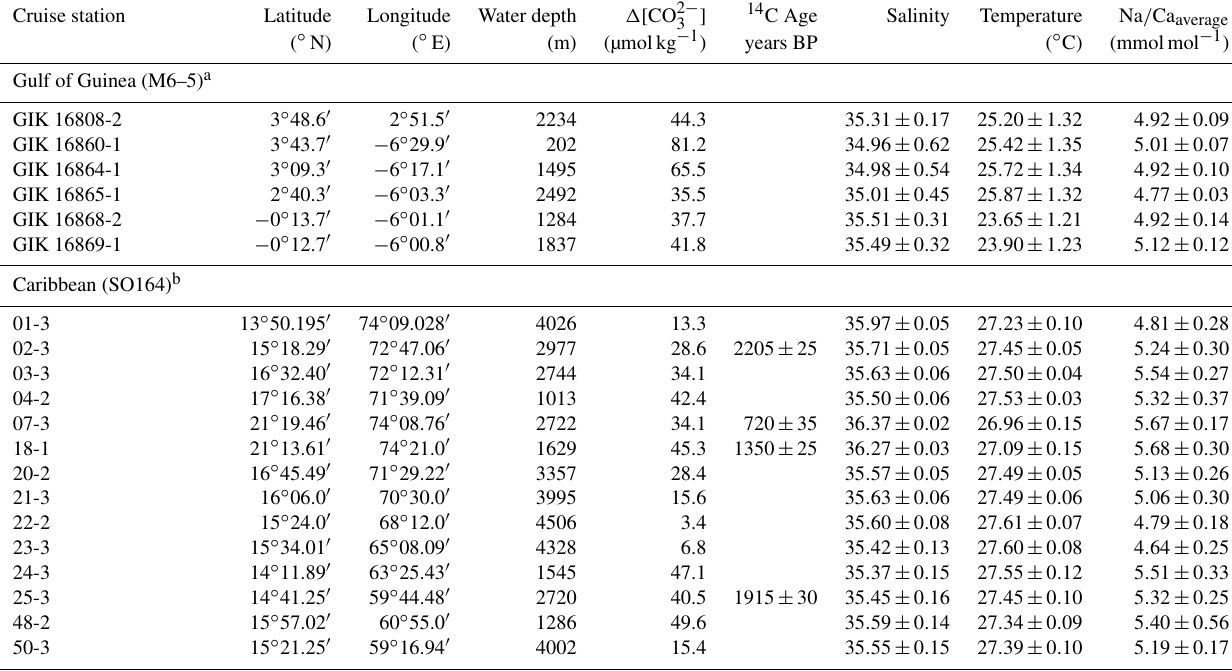
Table 1. Na / Ca values of T. sacculifer from surface sediment samples obtained from different core locations in the Gulf of Guinea a (Lutze et al., 1988) and the Caribbean b (Nürnberg et al., 2003). Foraminifera were selected from the uppermost sediment layer (0–1cm). The salinity and temperature data present averaged annual values at 30m of water depth with ± variations of these parameters between 0 and √ n ). Na / Ca values a , b were measured by an ICP-OES 60m of water depth (WOA13), shown as the standard error of the mean, SEM ( σ/ ] at bottom waters of respective sampling locations were taken from ( ± SEM of replicated measurements). Calcite saturation states (cid:49) [ CO 2 − 3 Regenberg et al. (2006, Caribbean) and Weldeab (2012, Gulf of Guinea). Additional data were calculated with the program CO2SYS by Pierrot et al. (2006) (see Sect. 2.3 for a detailed description). Radiocarbon (AMS 14 C) ages before present (BP) are published in Regenberg et al.